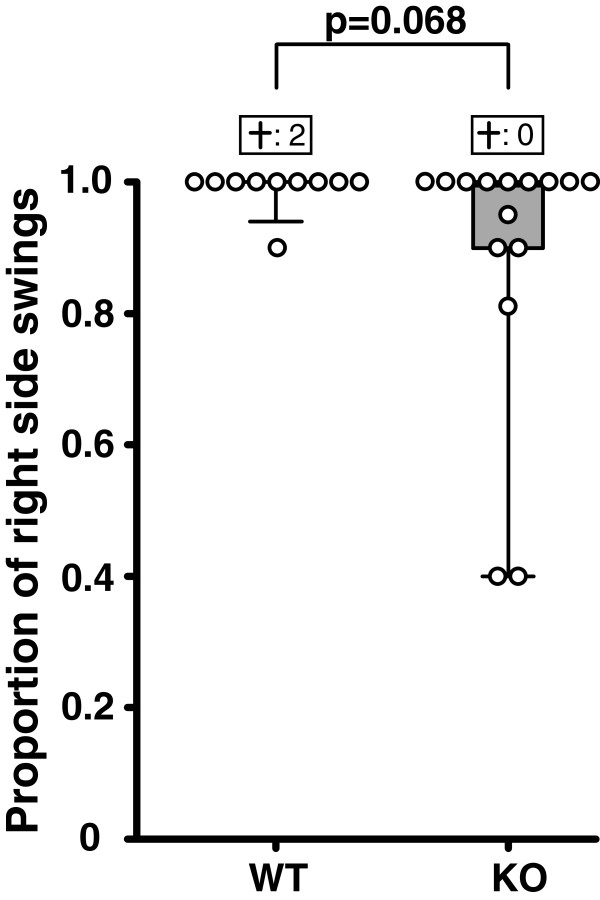
Tendency of improved functional outcome in FLAP knockout mice. No significant effect of the genotype difference was found in the mortality-adjusted tail swing test, although a trend of better performance in the knockout group was seen (p = 0.068). The proportion of right sided swings is plotted on the Y-axis. The segments of the box plots depict the 10th, 25th, 50th, 75th and 90th percentile. The boxes above the box plots represent the mortality in the two groups. WT = Wild type group, KO = FLAP knockout group.